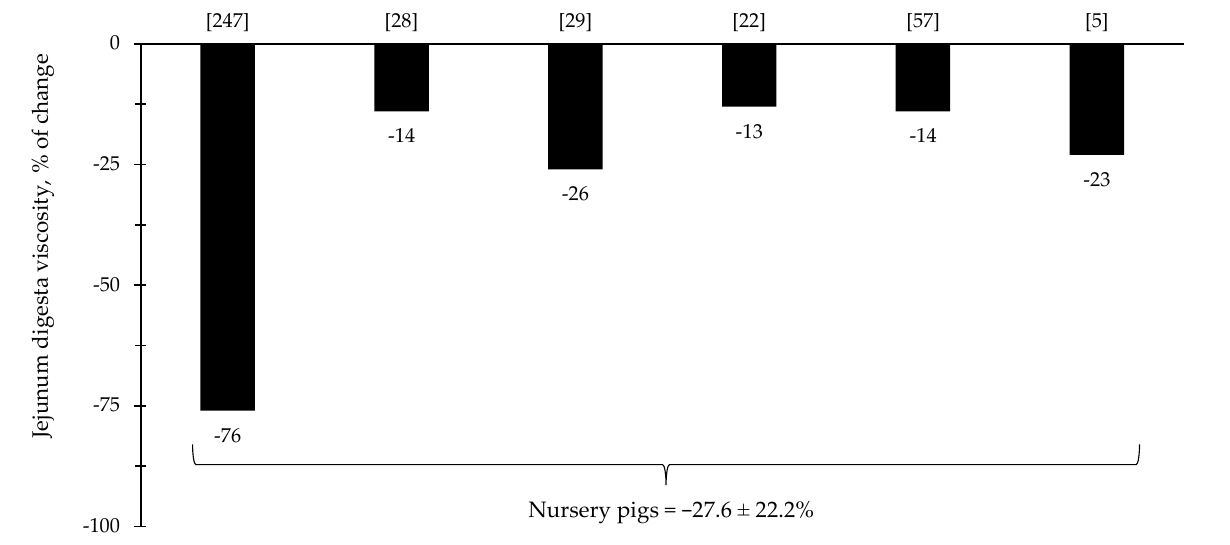
Nursery pigs = − 27.6 ± 22.2% Figure 10. Changes in the jejunum digesta viscosity of nursery pigs by xylanase supplementation among the studies displayed in Table 4 that showed changes in the jejunal digesta viscosity. The studies were selected from peer-reviewed literature available after 2000. The percentage of change refers to a statistically significant ( p < 0.05) and tendency (0.05 ≤ p < 0.10) effects of xylanase on the jejunal digesta viscosity reported from each respective study. The described effects were in comparison with treatments containing no xylanase. The average changes in the jejunal digesta viscosity of nursery pigs by xylanase supplementation were calculated excluding the studies that showed no effect.